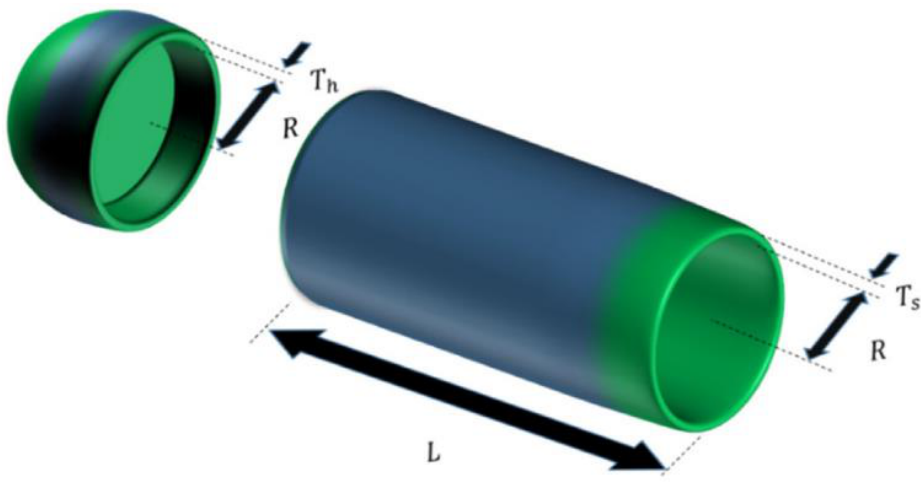
Figure 8. Structure of the pressure vessel. Table 10. Results of all 11 algorithms.